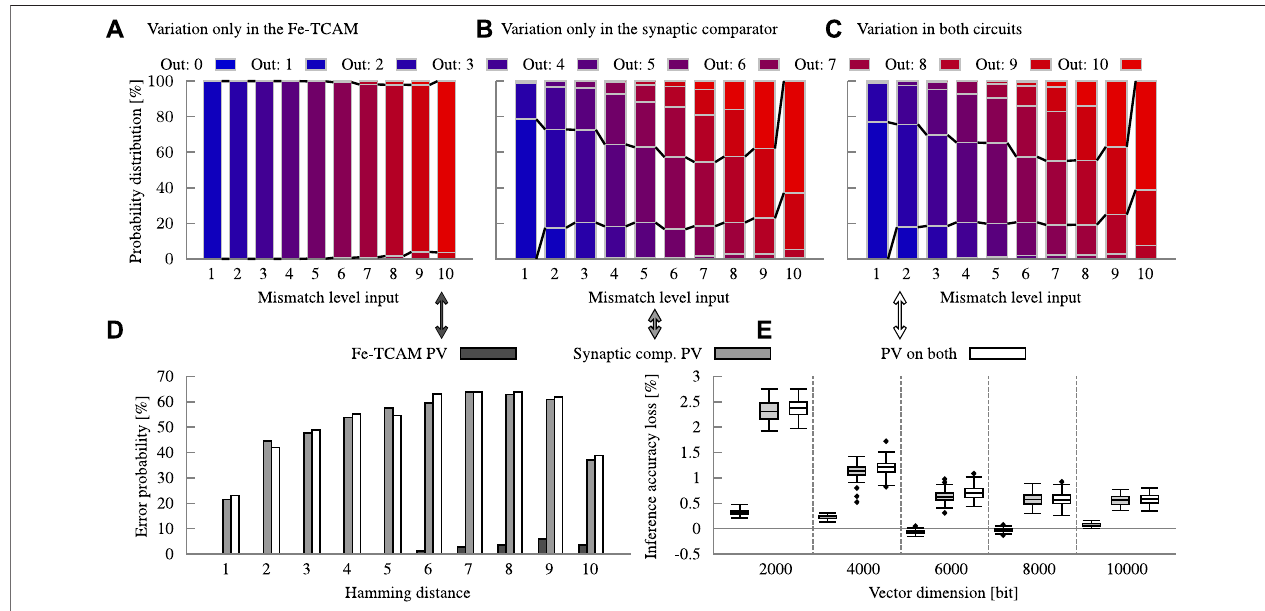
FIGURE13| Analysisofthe impact ofvariation on thetwomaincomponents in ourcircuit and its consequences. Variability in theFe-TCAMblockresults in almost no erroneous calculations whereas the synaptic comparator is the main source of errors when affected by variation, as shown in (A,B) , respectively. (C) shows the error model with both components under process variation (PV). (D) shows the summary in form of the error probability. (E) fi nally shows the resulting inference accuracy losses at the example of language recognition. All the analyses are done with a 10-bit Fe-TCAM block at a precision of 10 bit.